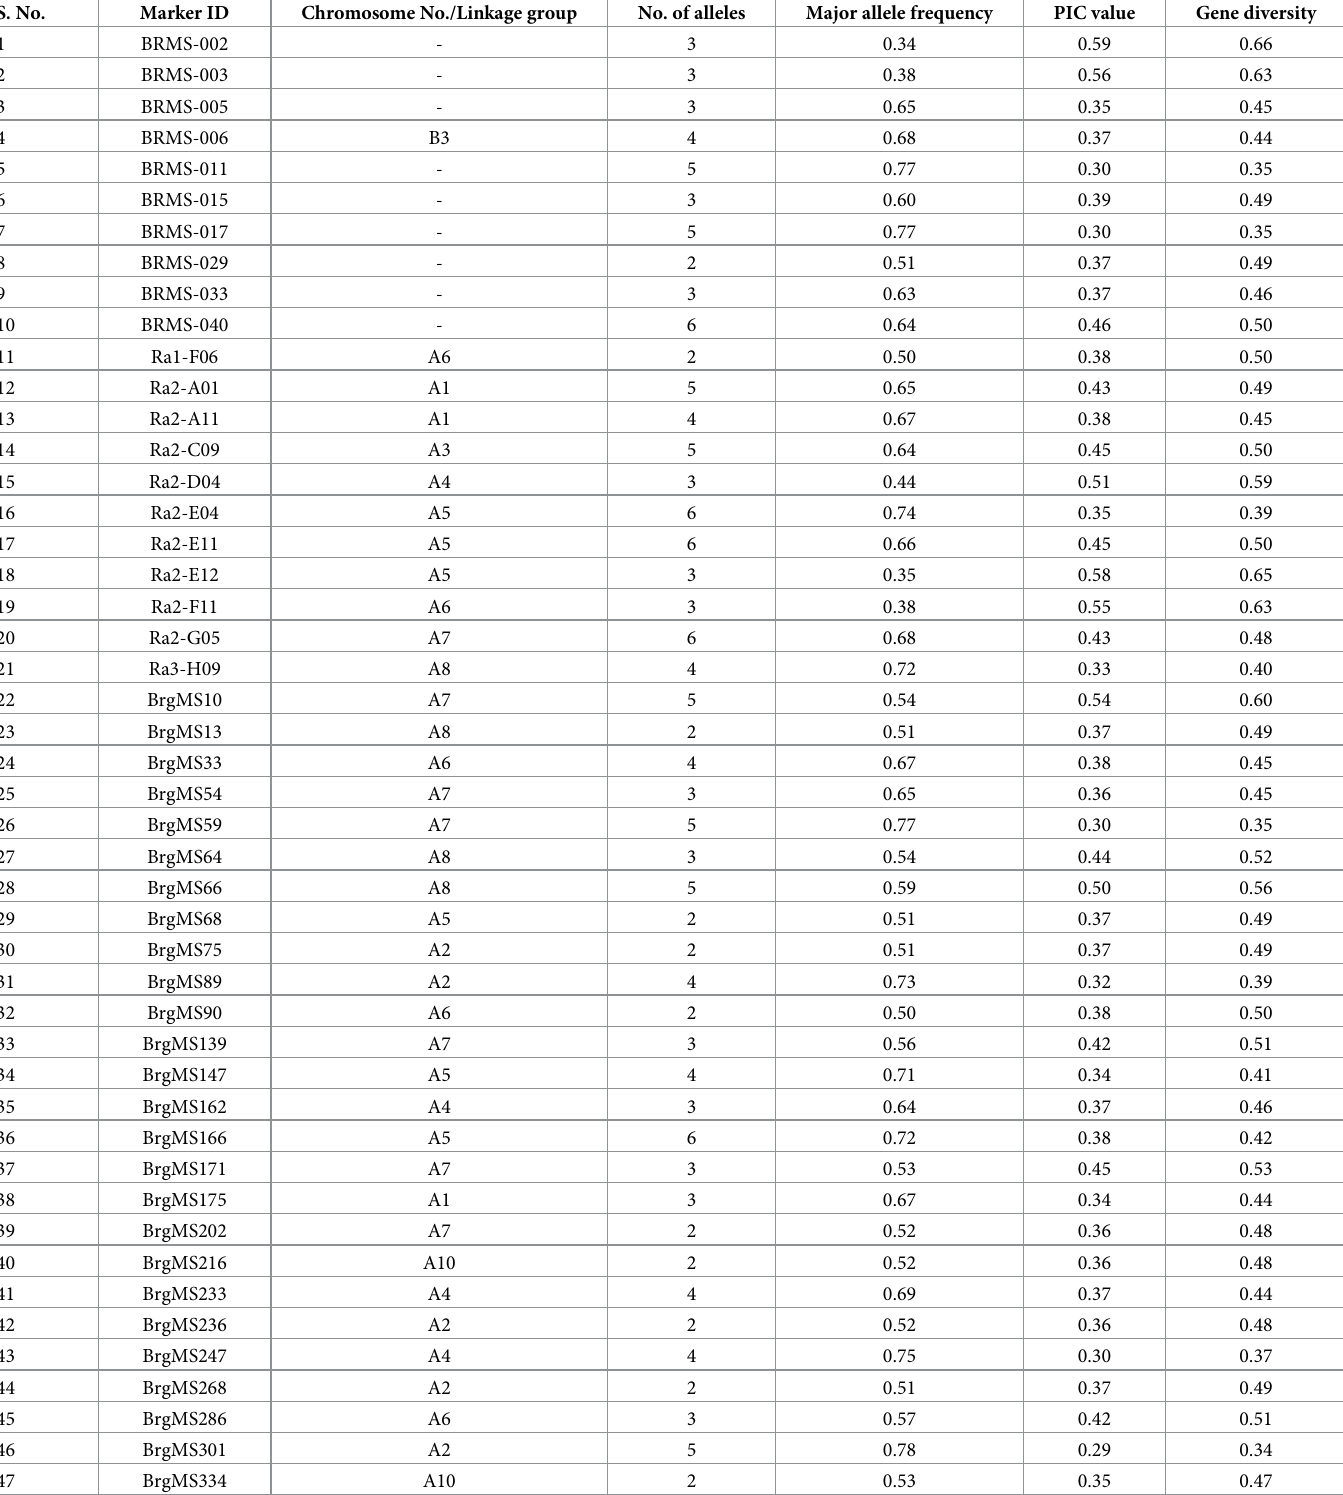
Table 2. Various allelic diversity parameters of polymorphic SSR markers used for genotyping of Indian mustard varieties. S.